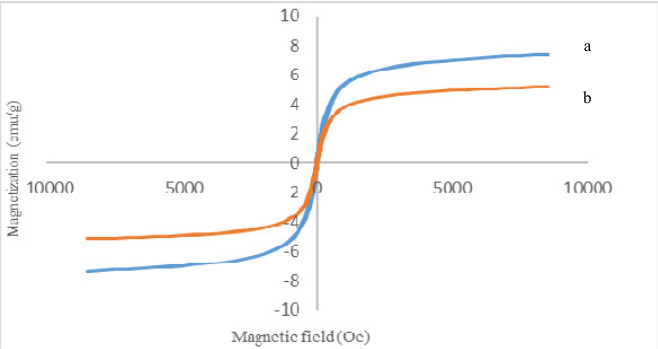
Fig. 2. Magnetization hysteresis loop behavior of Fe₃O₄ (a), Fe₃O₄@[NVC][AP] (b)